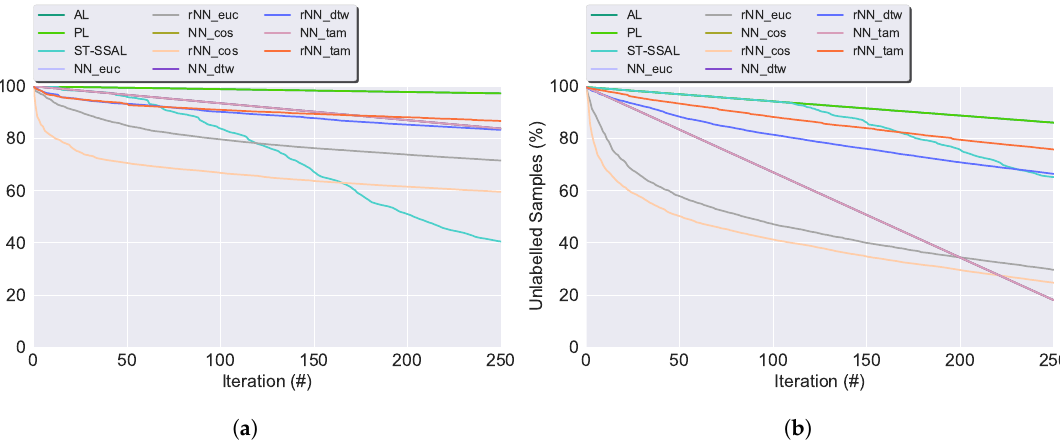
Figure 10. Evolution on the percentage of the validation set unlabelled samples for the SSAL methods throughout the AL cycle iterations. Following the underscore in the NN and rNN methods: Euc, Cos, DTW and TAM, denote the similarity distances used in the respective method. ( a ) UCI dataset. ( b ) CADL